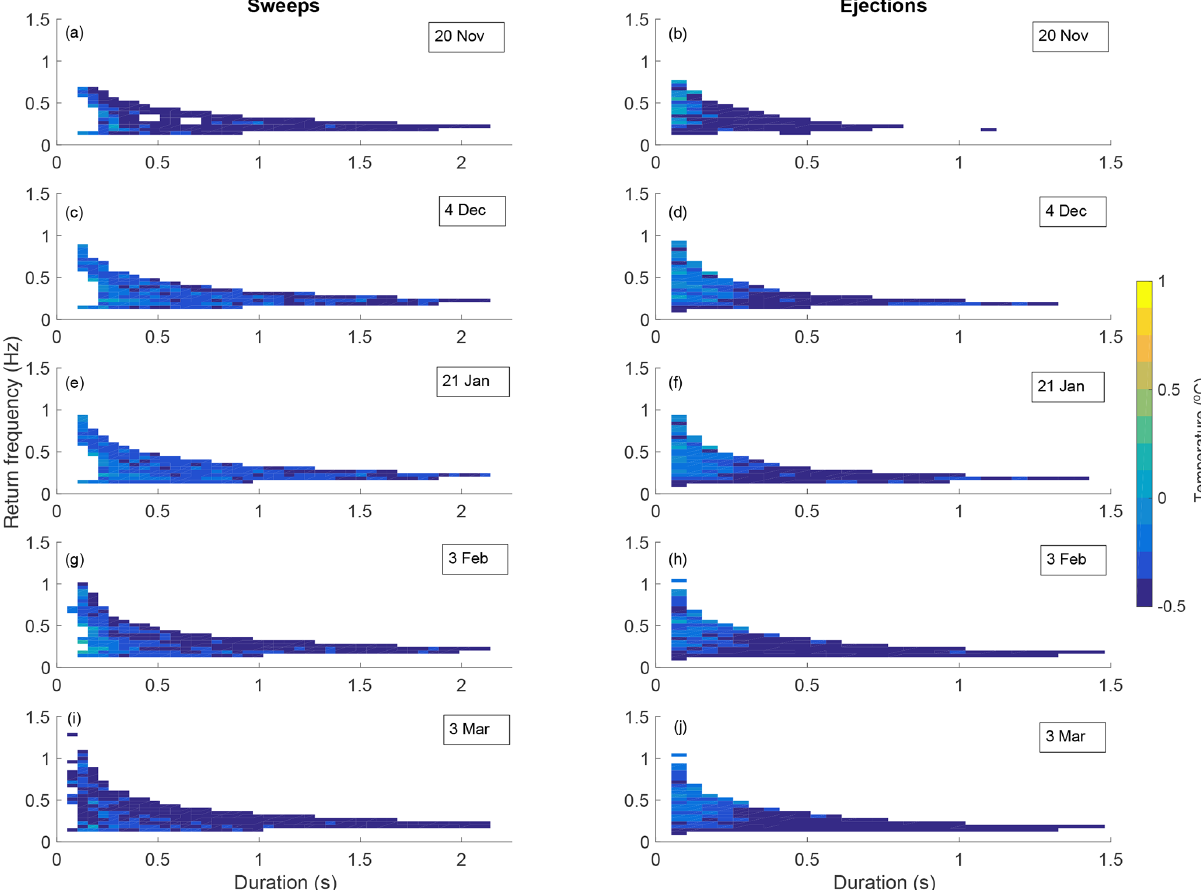
Figure 4. The same measurements as shown in Fig. 3, now subtracting the upper-anemometer (140cm above the surface) mean from the near-surface (20cm) sweep and ejection temperatures for various blowing snow storms. Note the predominantly colder